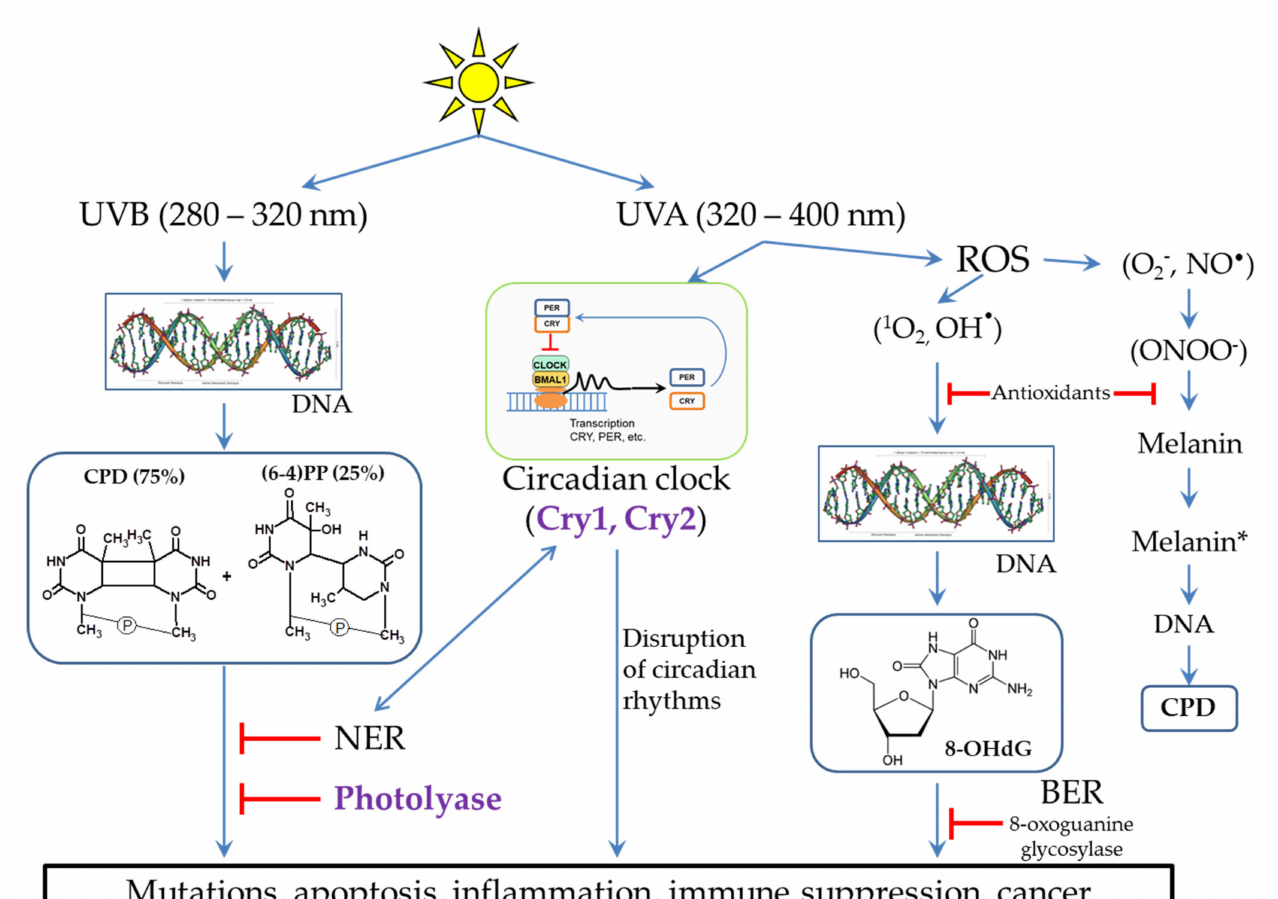
Figure 2. Different UV radiation of DNA leads to different lesions and subsequent occurrence of pathological situations. Methods of lesion prevention and repair are presented. * - The excited state of